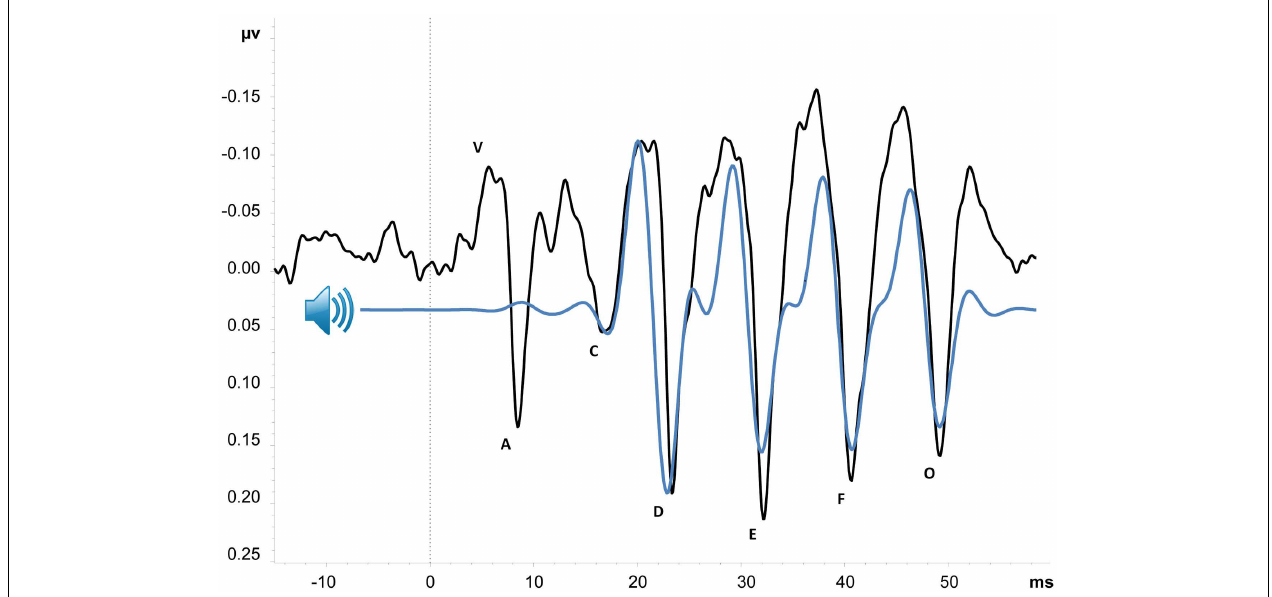
account for transmission time from cochlea to brainstem. PeaksV–A, C, and O are transient features of the cABR, corresponding with stop consonant onset, consonant-vowel formant transition, and offset of voicing, respectively. Peaks D, E, and F comprise the sustained frequency-following response (FFR) of the vowel sound (Tarasenko et al., in